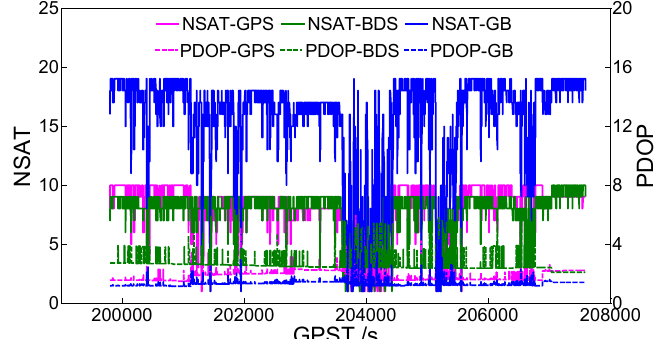
Figure 8. Number of satellites (NSATs) and the PDOP value. GB denotes GPS + BDS. Table 5. Positioning precision statistics.